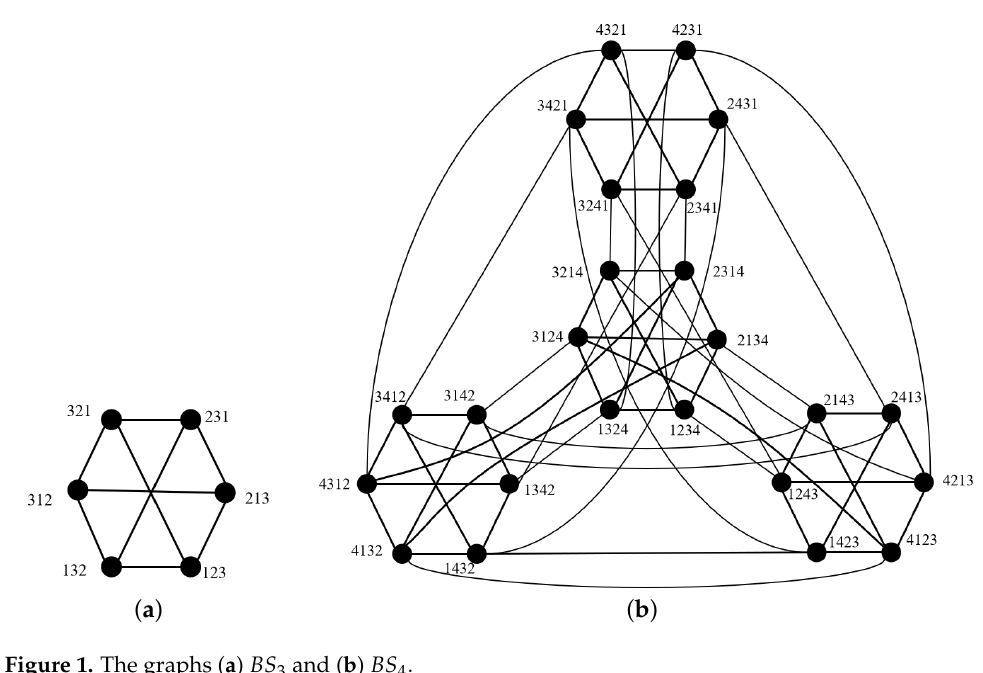
Figure 1. The graphs ( a ) BS 3 and ( b ) BS 4